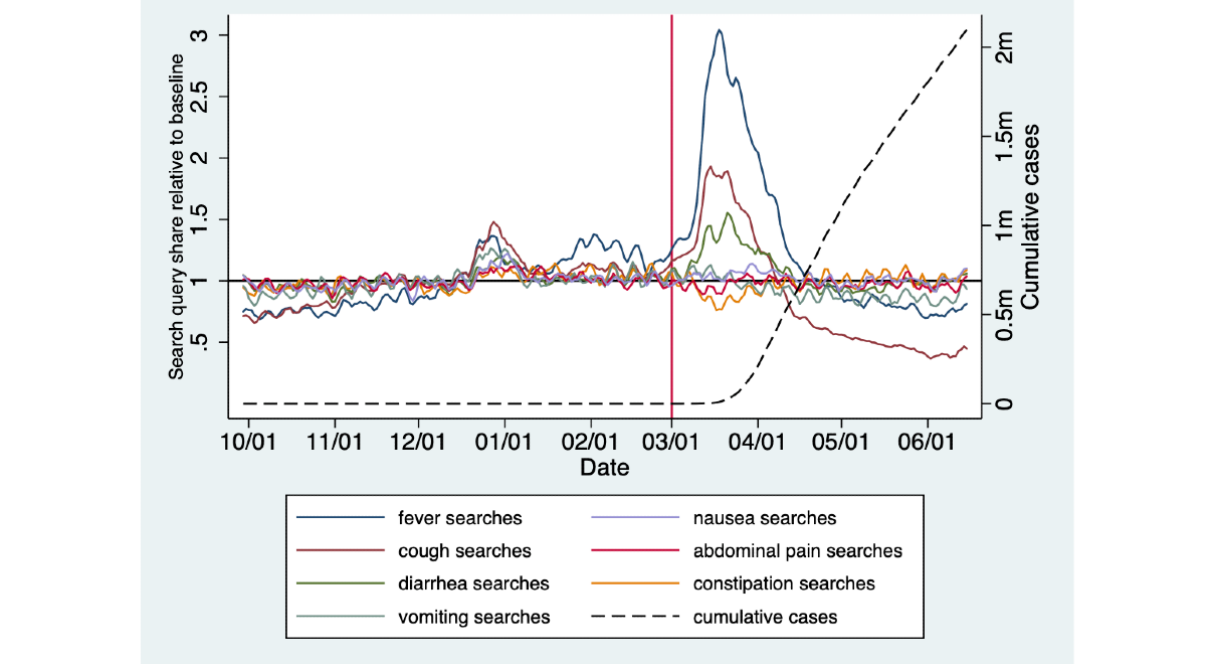
Figure 1. Google search query shares for gastrointestinal symptoms, fever, and cough relative to the pre-March 1, 2020 baseline and their relationships